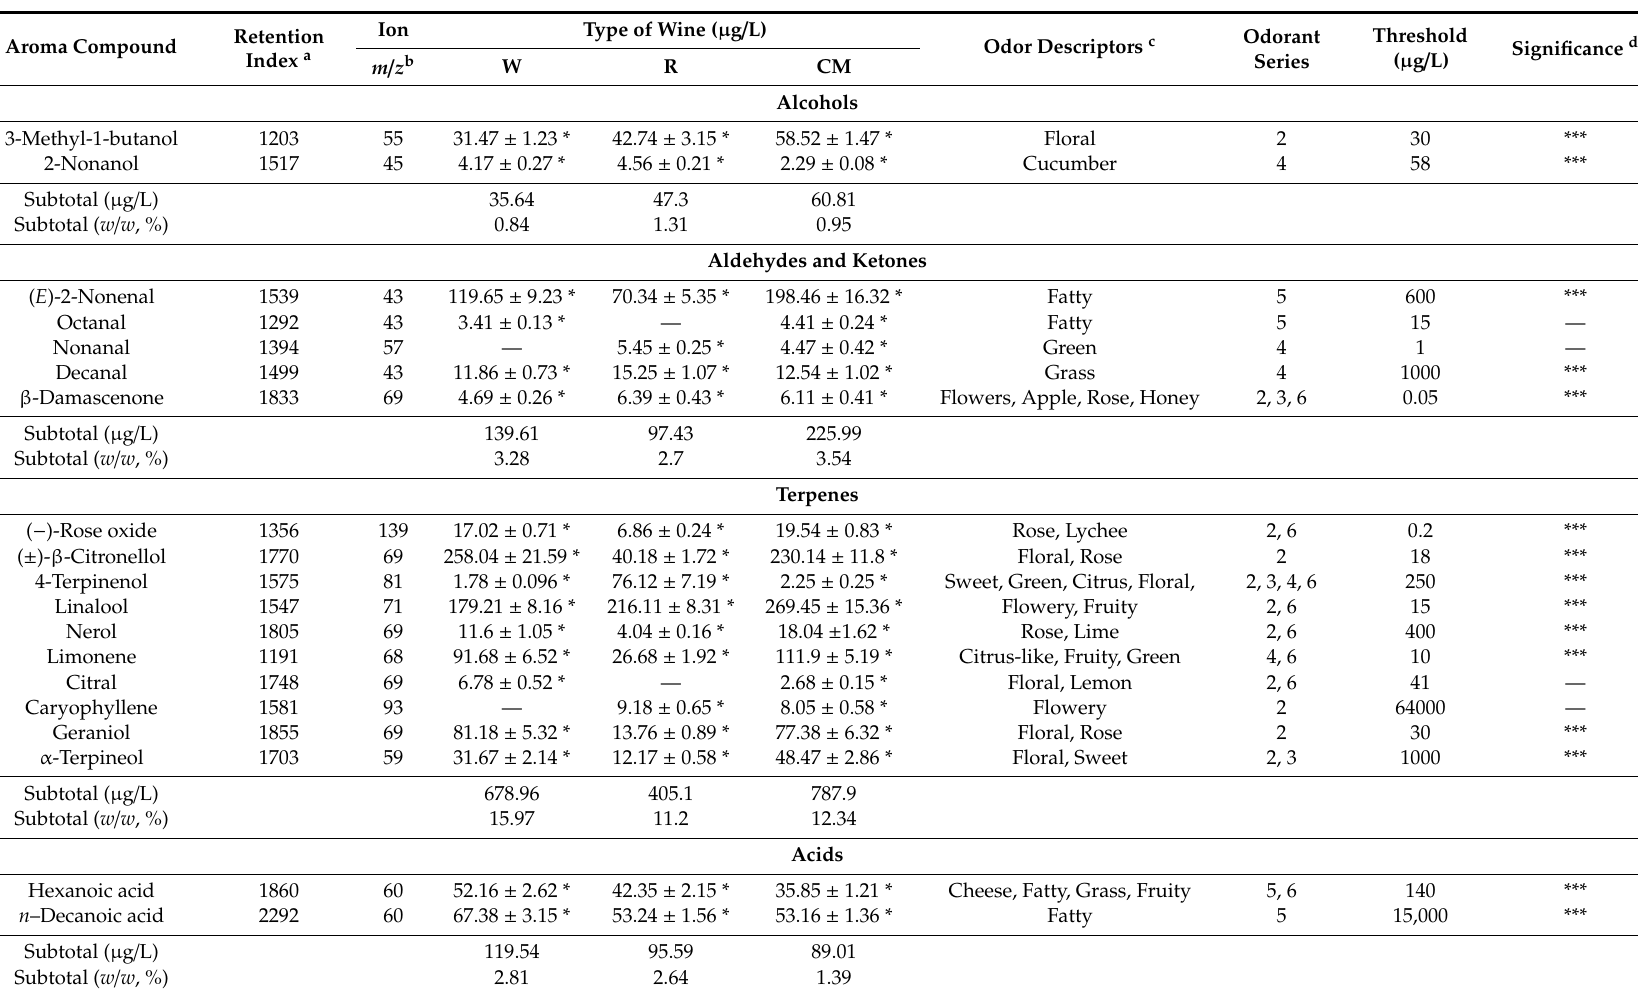
Table 3. The impact of di ff erent fermentation technologies on wine aroma compounds in Muscat Hamburg